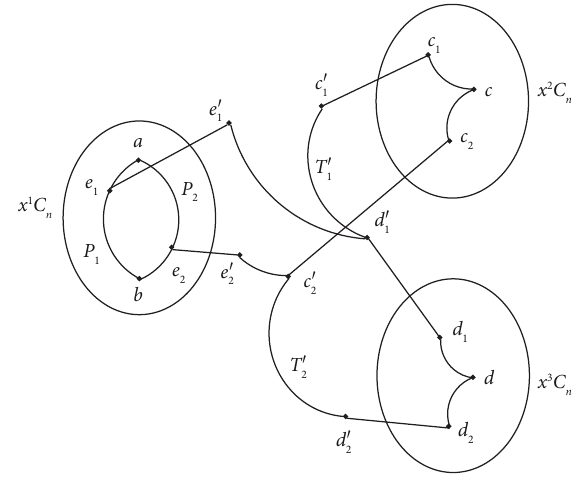
Figure 5: Te illustration of case 3 of Teorem